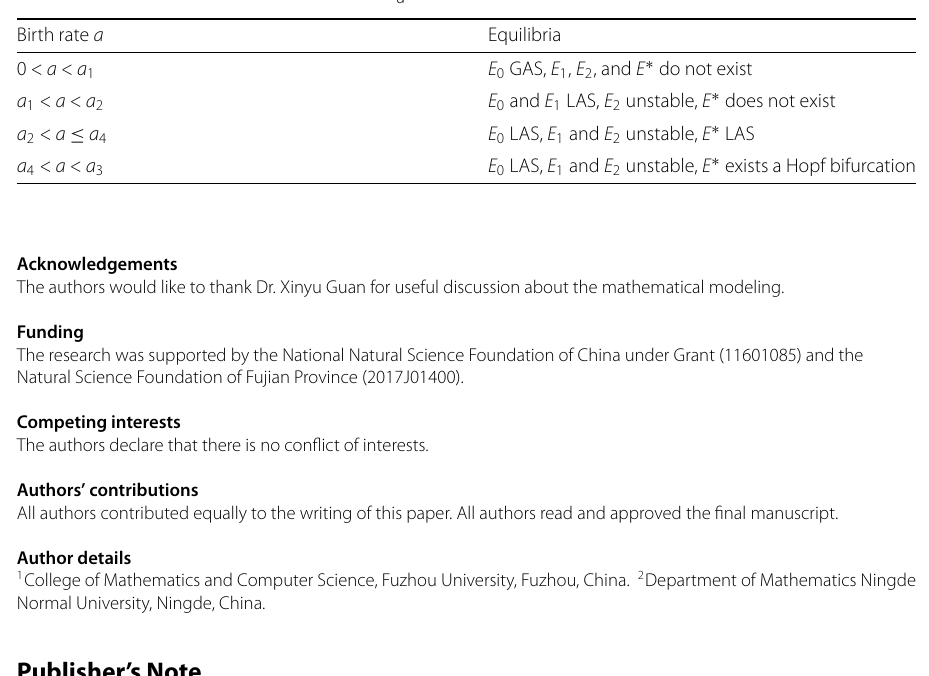
Table 6 System (4) with Q 0 > 0 and A < b ( x